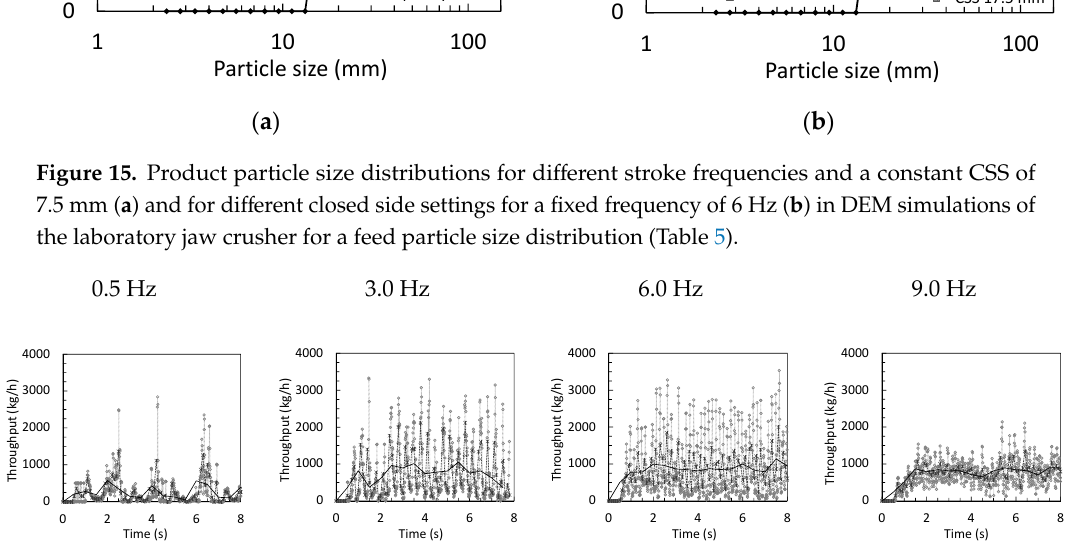
Figure 15. Product particle size distributions for different stroke frequencies and a constant CSS of 7.5 mm ( a ) and for different closed side settings for a fixed frequency of 6 Hz ( b ) in DEM simulations of the laboratory jaw crusher for a feed particle size distribution (Table 5).